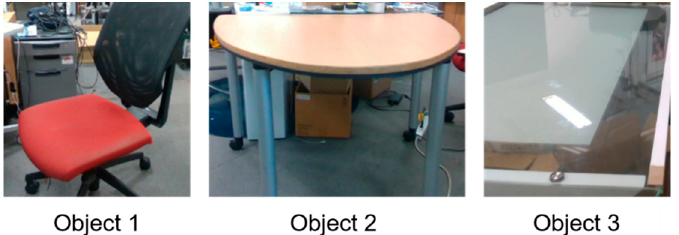
Figure 6. Examples of images acquired by object recognition in the usage environment. Table 2. Ratio classified into each material label.